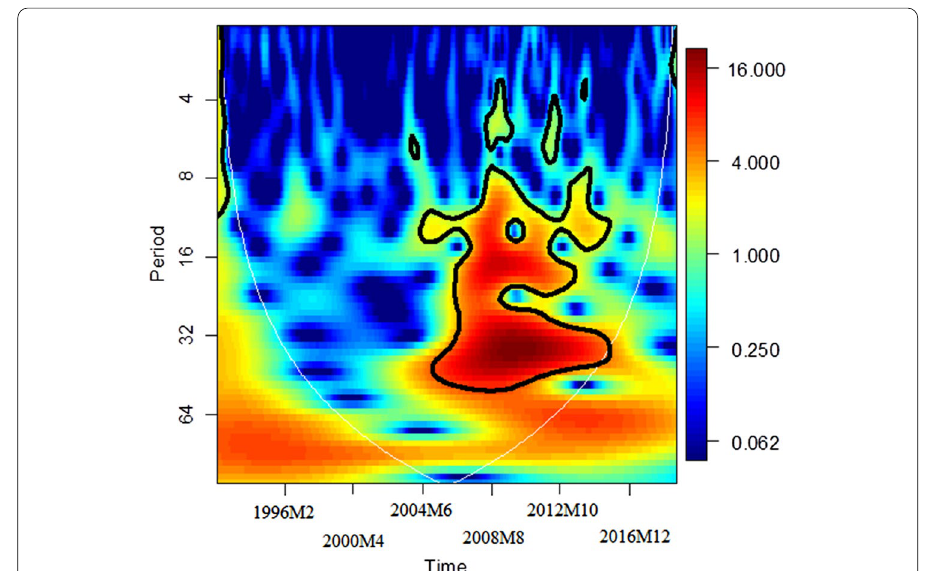
Fig. 3 Wavelet power spectrum for agricultural raw materials index